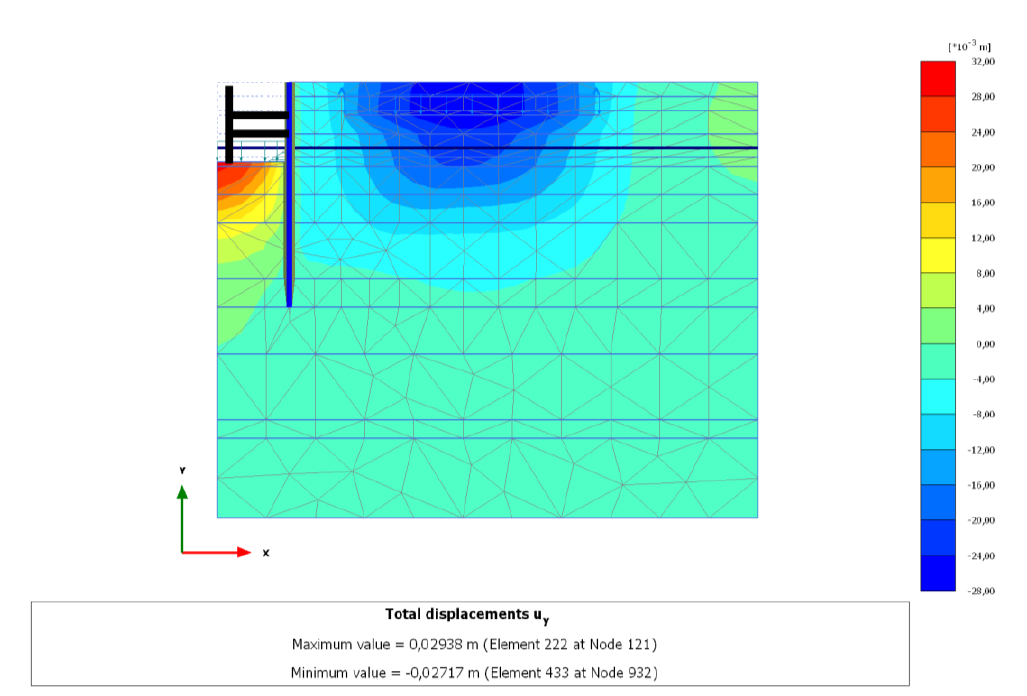
Figure 10. Total displacements along Y